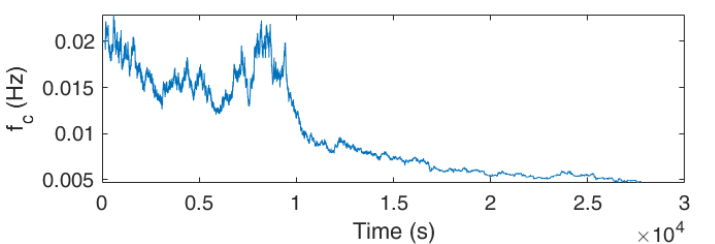
Figure 5. Adapt the cutoff frequency f c in the case giving an improper